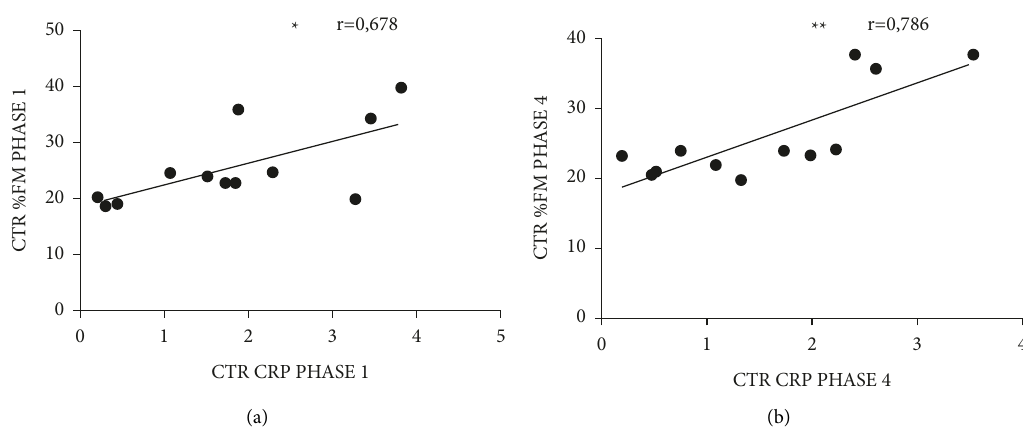
Figure 3: Correlation analysis. CTR—healthy control group, n per liter (ml/L); %FM—fat mass expressed as a